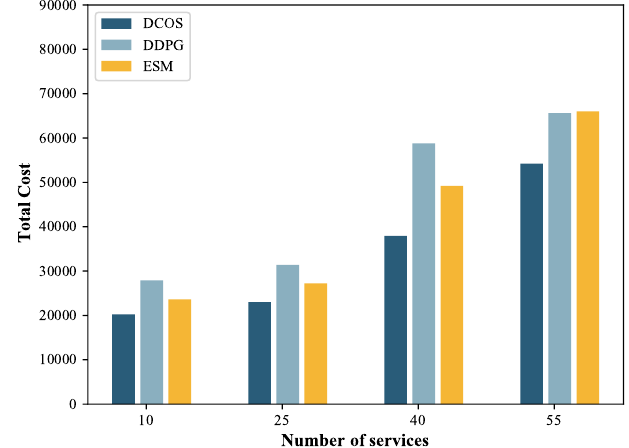
Figure 9. Total cost comparison for different service